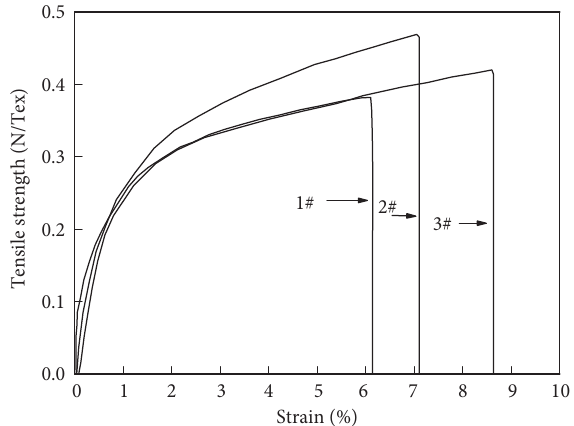
Figure 8: Curve of stress-strain of the carbon nanotube yarn.